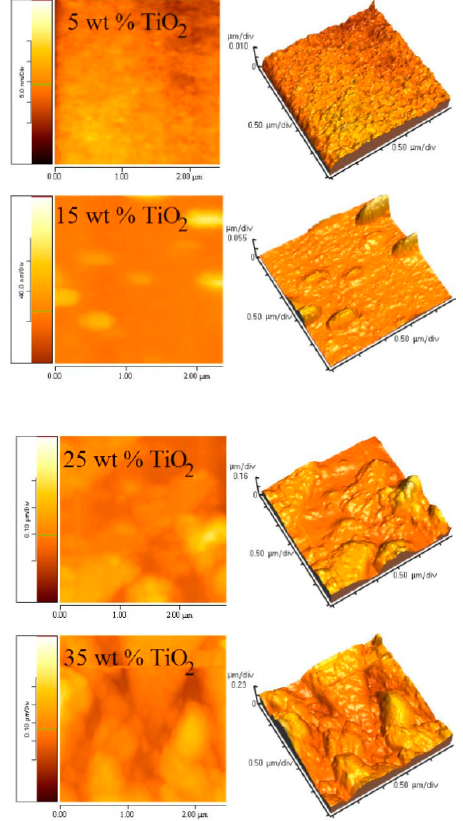
Figure 6. 2D and 3D SPM images of PFO/0.5 wt % Fluorol 7GA blends with different content of TiO 2 NPs, measured over an area of 2.5 × 2.5 μ m 2 .